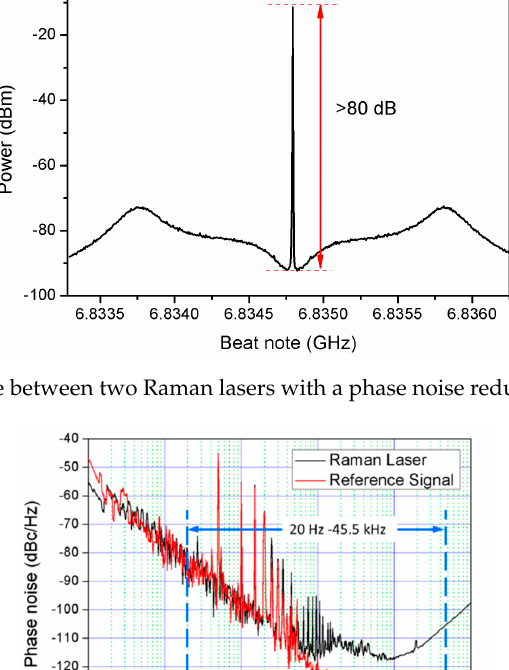
Figure 3. Raman lasers’ relative phase noise power spectrum destiny. Red line is the phase noise power spectrum destiny (PSD) of the reference signal and the black one is the Raman